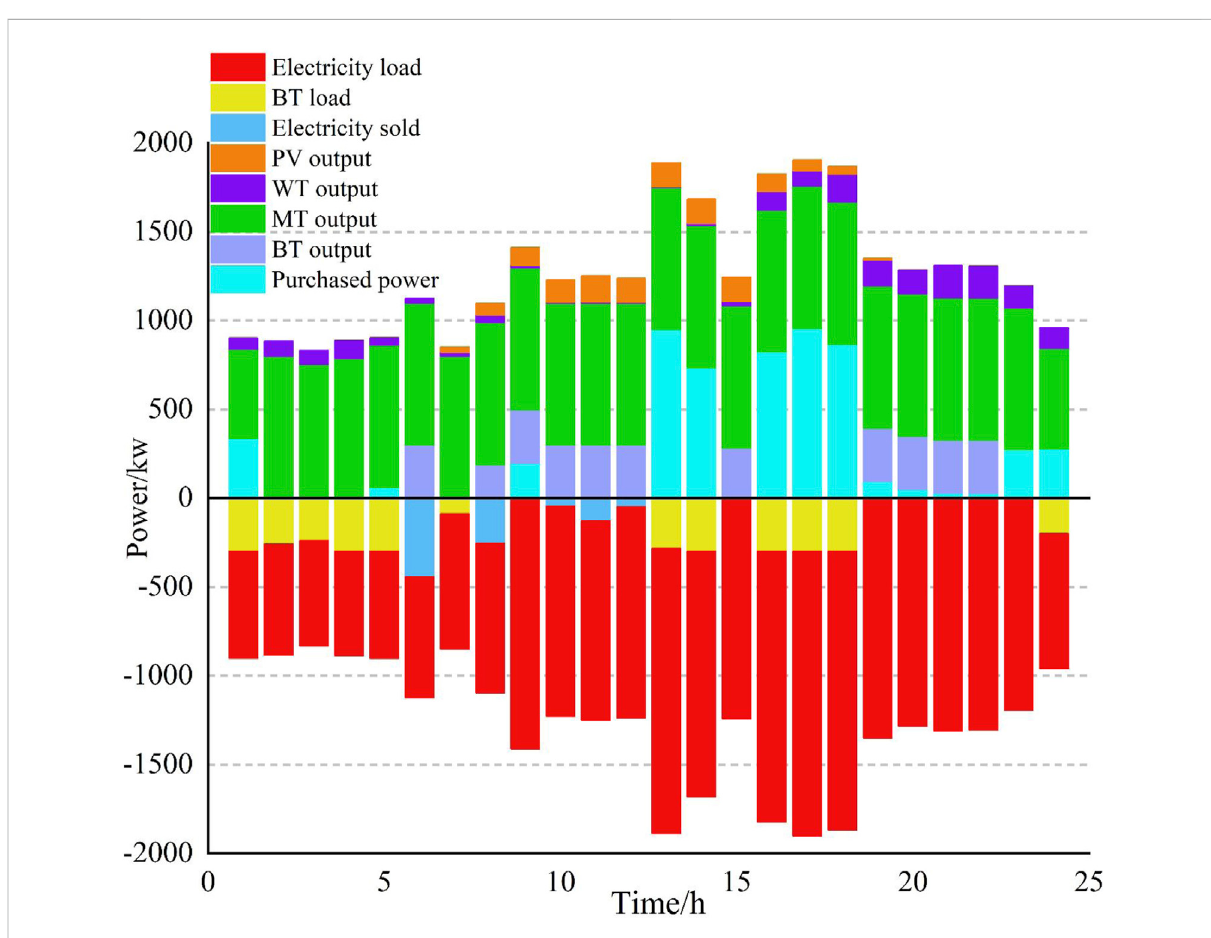
FIGURE 8 Case 3: power of each subject after